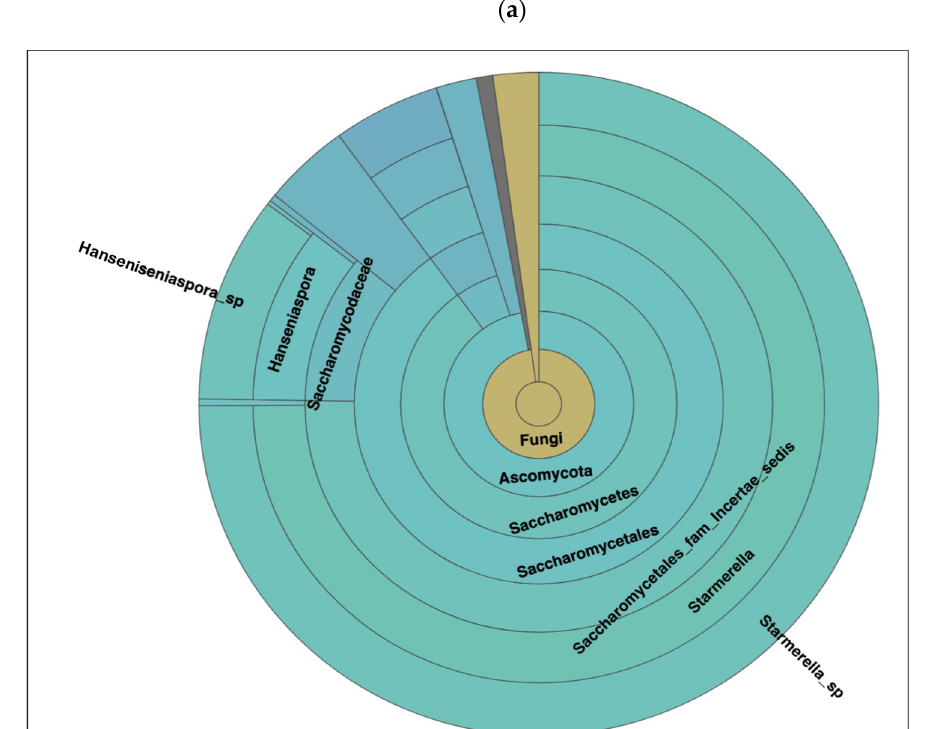
Figure 6. ( a ) Different dominant yeast species in kombucha samples. Starmerella Starmerella is the most abundant species followed by Galiella Galiella rufa species. The error bars are standard error (SE) calculated across the triplicate values of samples. ( b ) Sunburst chart shows the relative abundance of the yeast classification within each taxonomic level. Kingdom: Fungi; Phylum: Ascomycota; Class: Saccharomycetes; Order:Sccharomycetales; Family: Saccharomycetales_fam_Incertae_sedis; Genus: Starmerella and Hanseniaspora ; Species Starmerella_sp and Hanseniaspora sp .